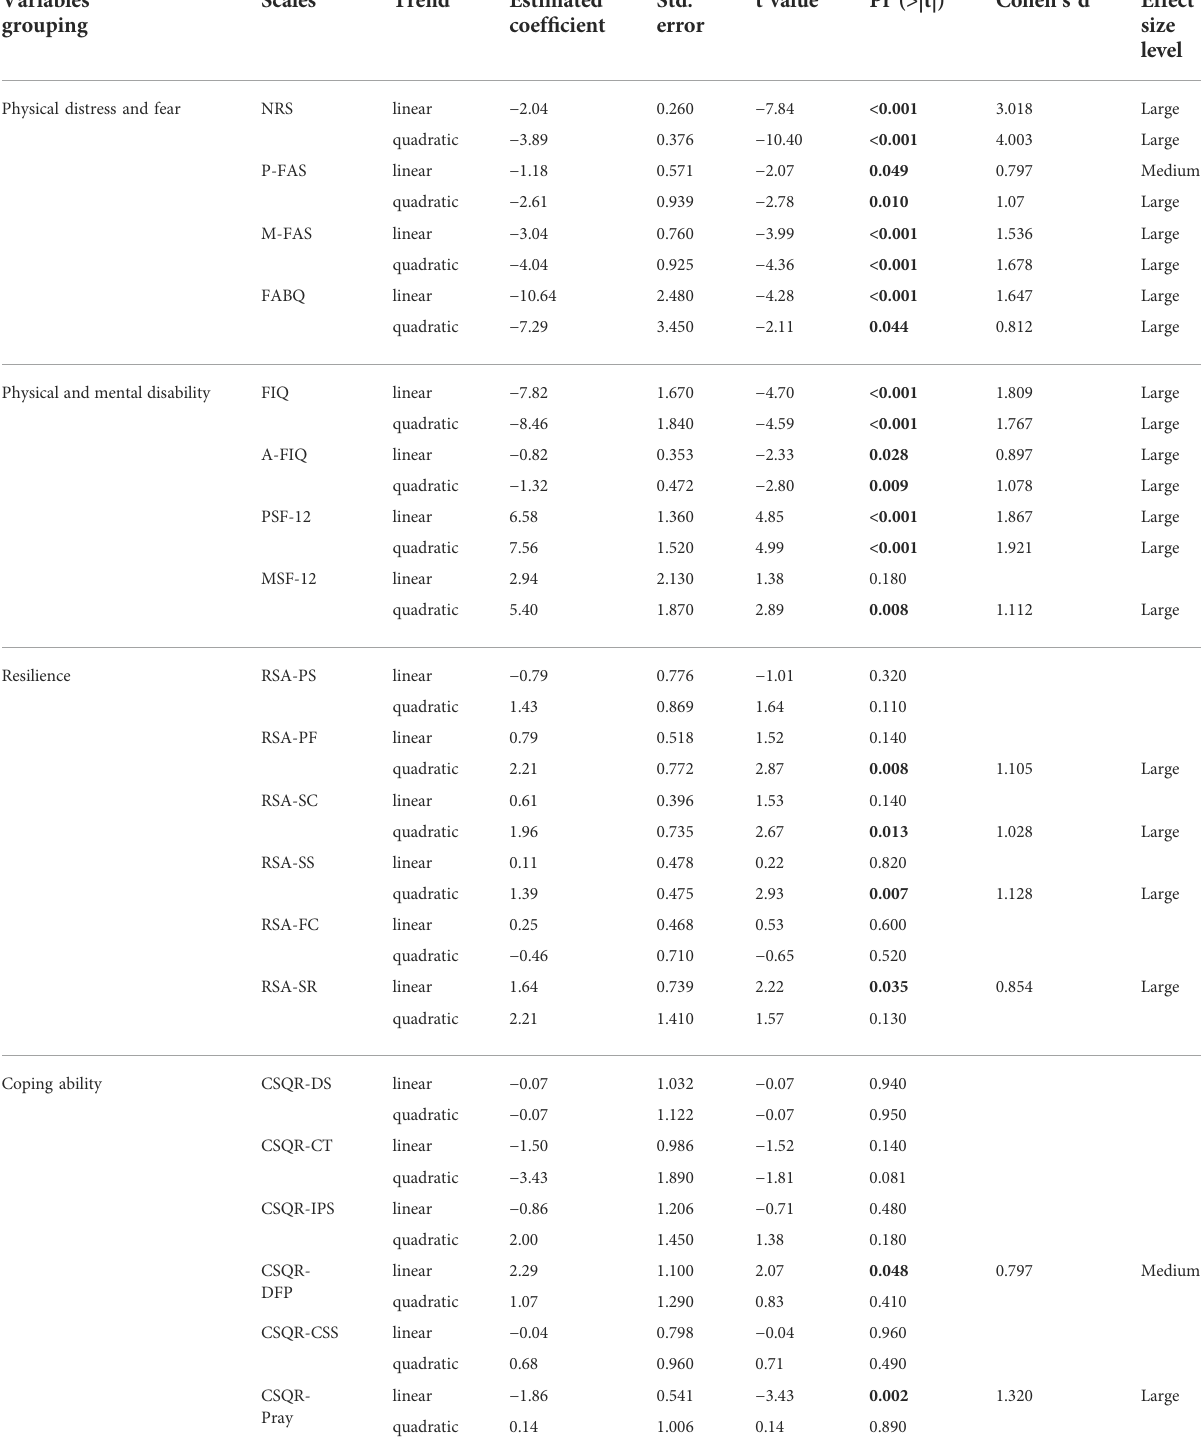
TABLE 2 Regression analysis of linear and quadratic trends for time series (T0, T1, and T2) of scales of physical distress and fear, physical and mental disability,resilience, and copingability. Signi fi cant valuesof tprobabilities arereported inboldtype. Negative coef fi cientsindicate a reductionin scale scores, while positive coef fi cients indicate an increase in time